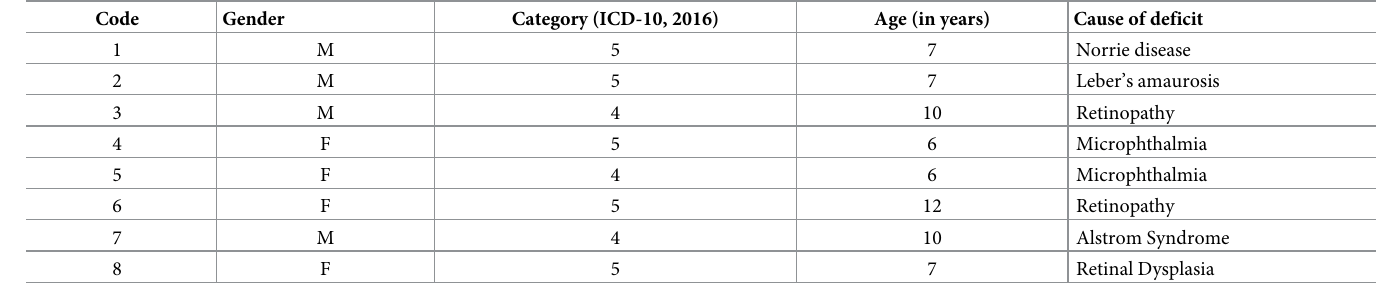
Table 1. Characteristics of early blind children who participated in Experiment 1: Identification of action objects engaging the ASFG